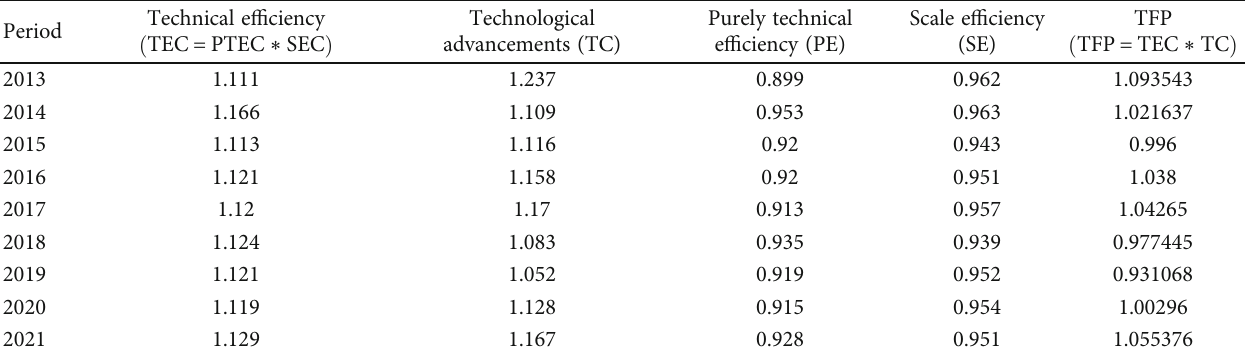
Table 4: Mean value of Malmquist indexes and its decomposing results on urban land use in the land economic zone.